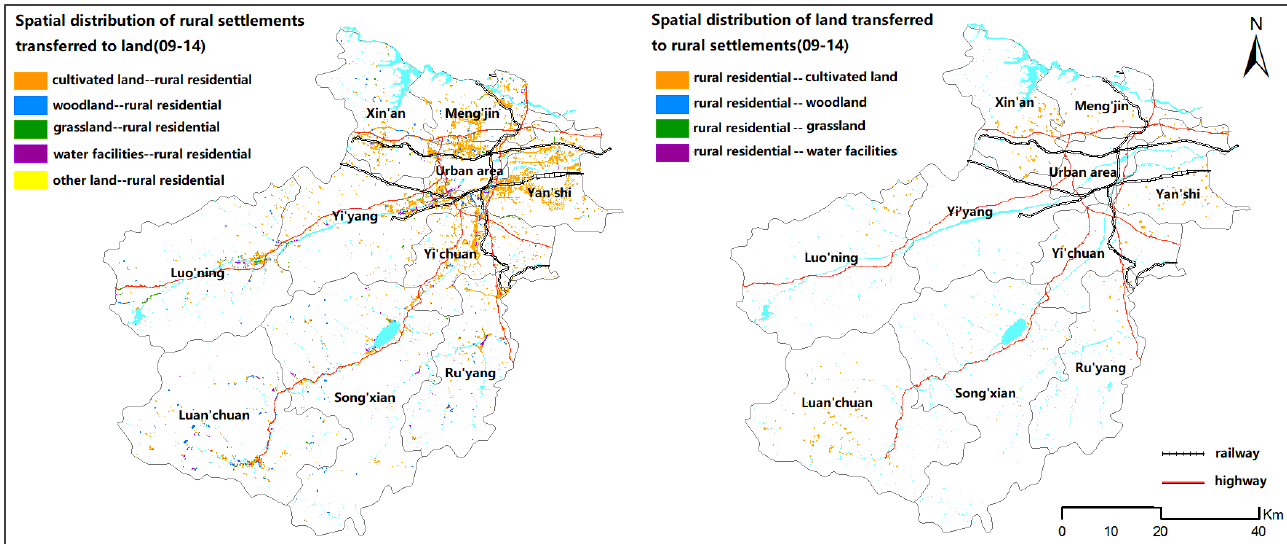
Figure 5. Spatial Distribution of Land Types Transferred to and from Rural residentials in Luoyang region (2009 – 2014).